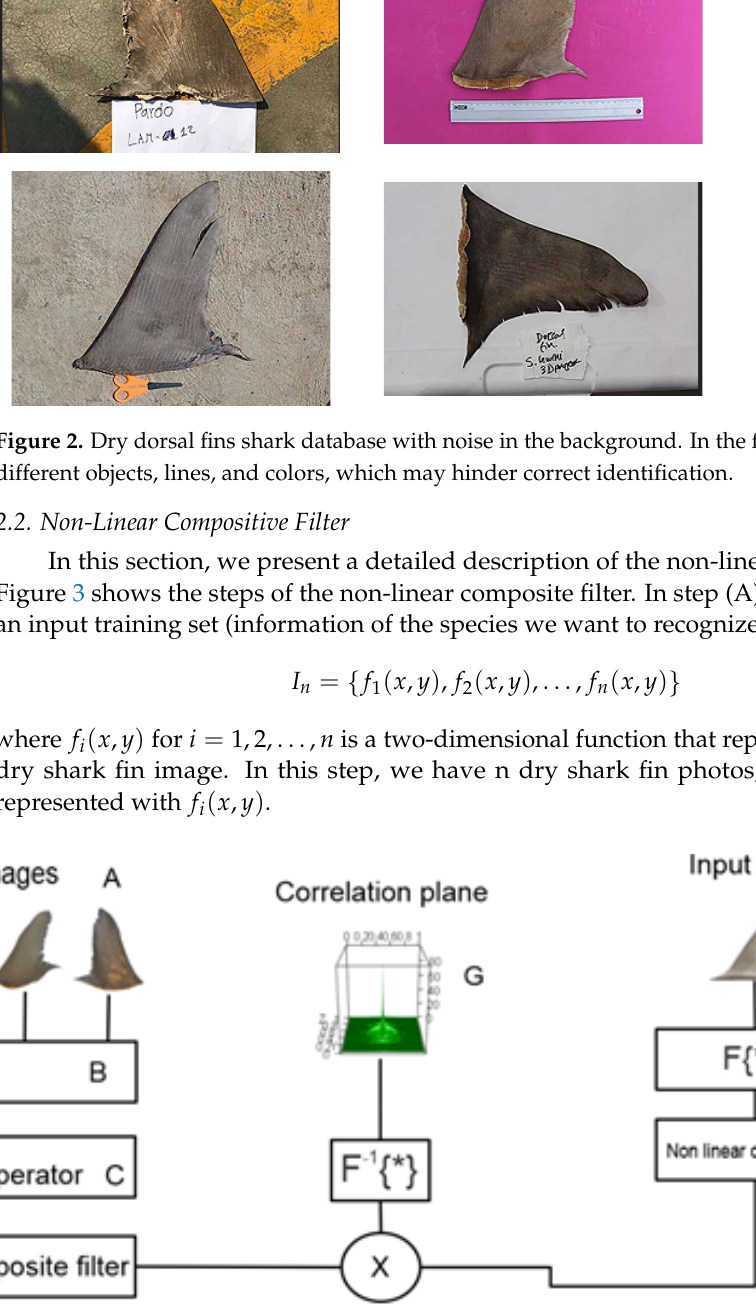
Figure 1. Dry shark fins from the first dry fin shark species up to the last dry fin shark species. ( A , C ) are Sphyrna lewini, ( B ) is Sphyrna mokarran and ( D ) is Alopias pelagicus. Database without noise in the background.